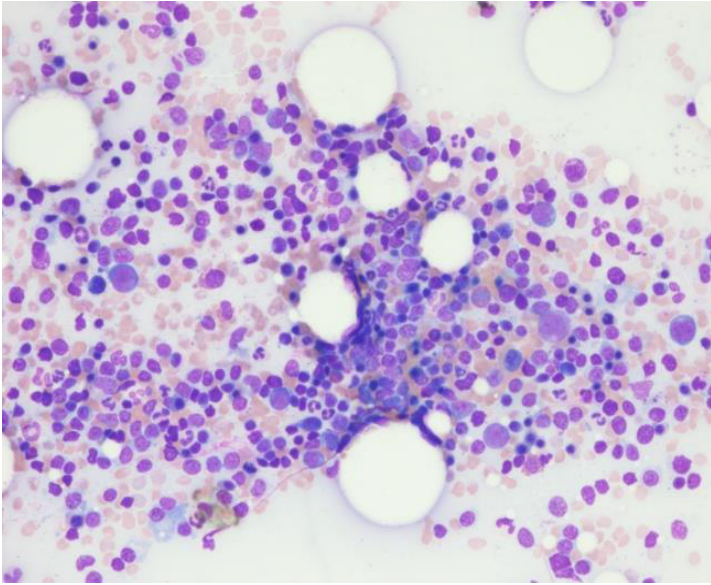
Figure 2. Bone marrow aspirate with trilineage hematopoiesis and increased lymphocytes.